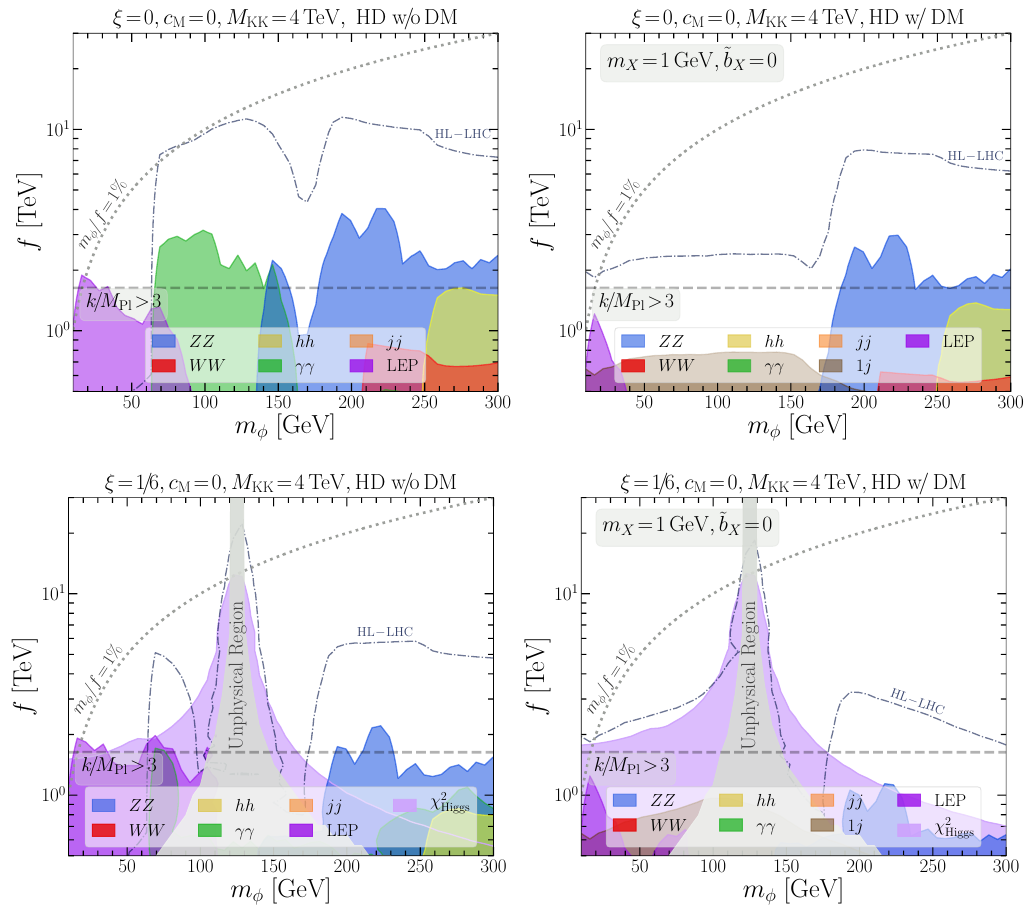
Figure 5 . Exclusion bound on the holographic dilaton parameter space in the m (cid:30) vs f plane. The gray region in the lower-panel plots corresponds to the unphysical